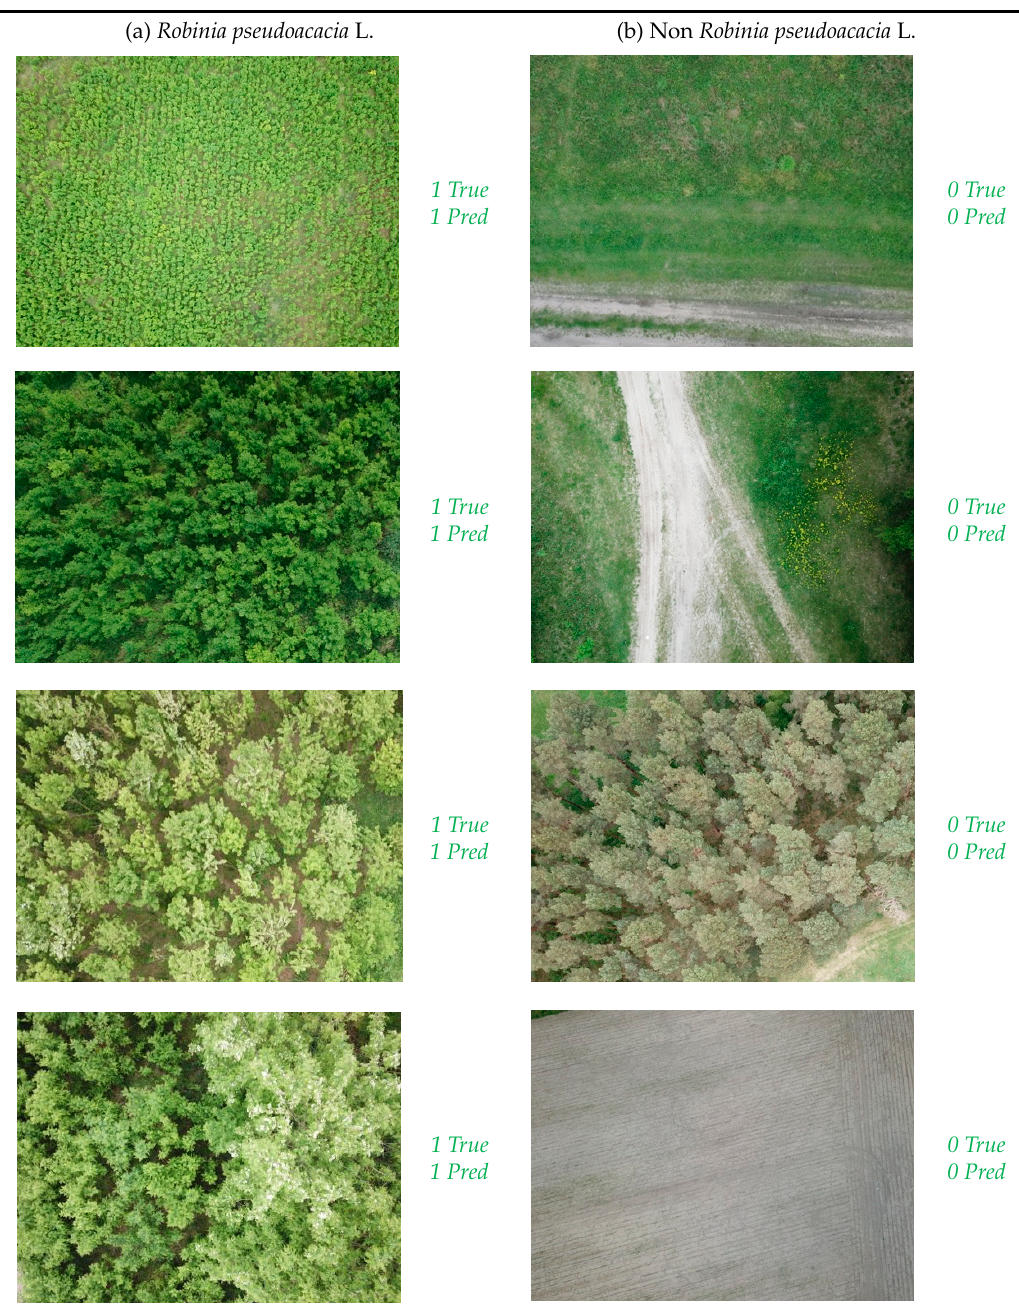
Table 6. Classification examples of the test data set; R. pseudoacacia (( a ), category 1) and Non- R. pseudoacacia (( b ) category 0): meadow, dirt road, pine forest, and farmland. Pred is the abbreviation for Prediction. True and the green color of the labels show that the prediction (output in Figure 3) and the class (input in Figure 3) are equal.